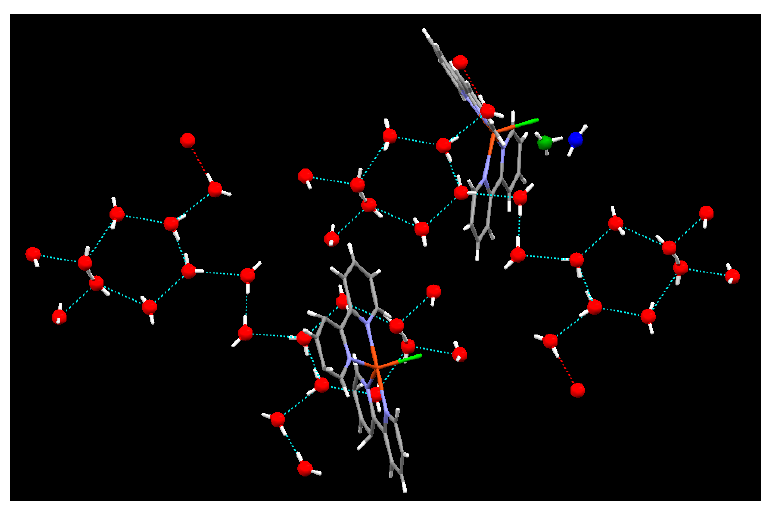
Figure 1. Packing of anion water clusters [(H 2 O) 18 (OH) 2 ] n 2 n − and three H 2 O and the cation [CuCl(bipy) 2 ] + moiety along the pc plane. Red ball represent water cluster, blue ball is O4w, and green ball is O5w.